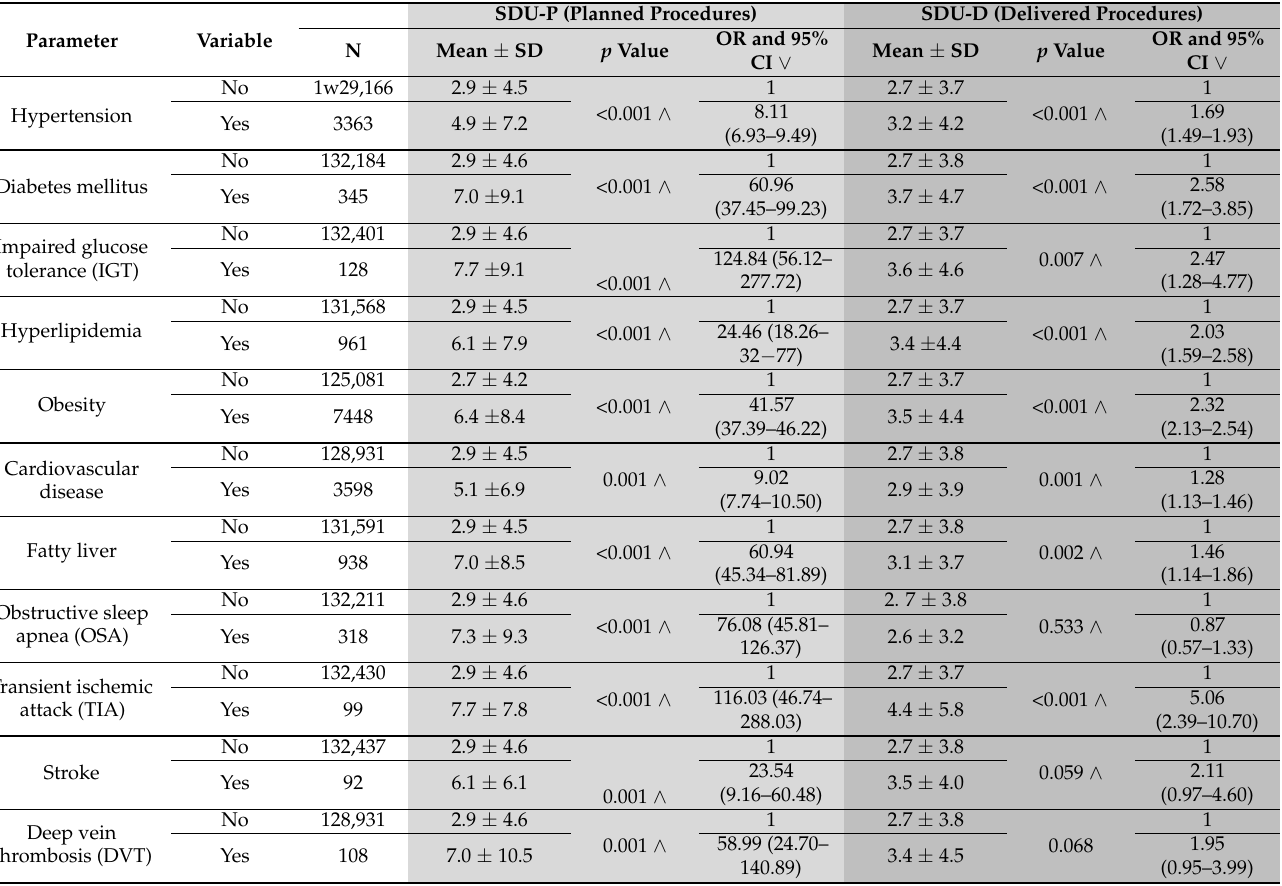
Table 3. The associations of SDU-P (planned procedures) and SDU-D (delivered procedures) with MetS components, consequences, and related